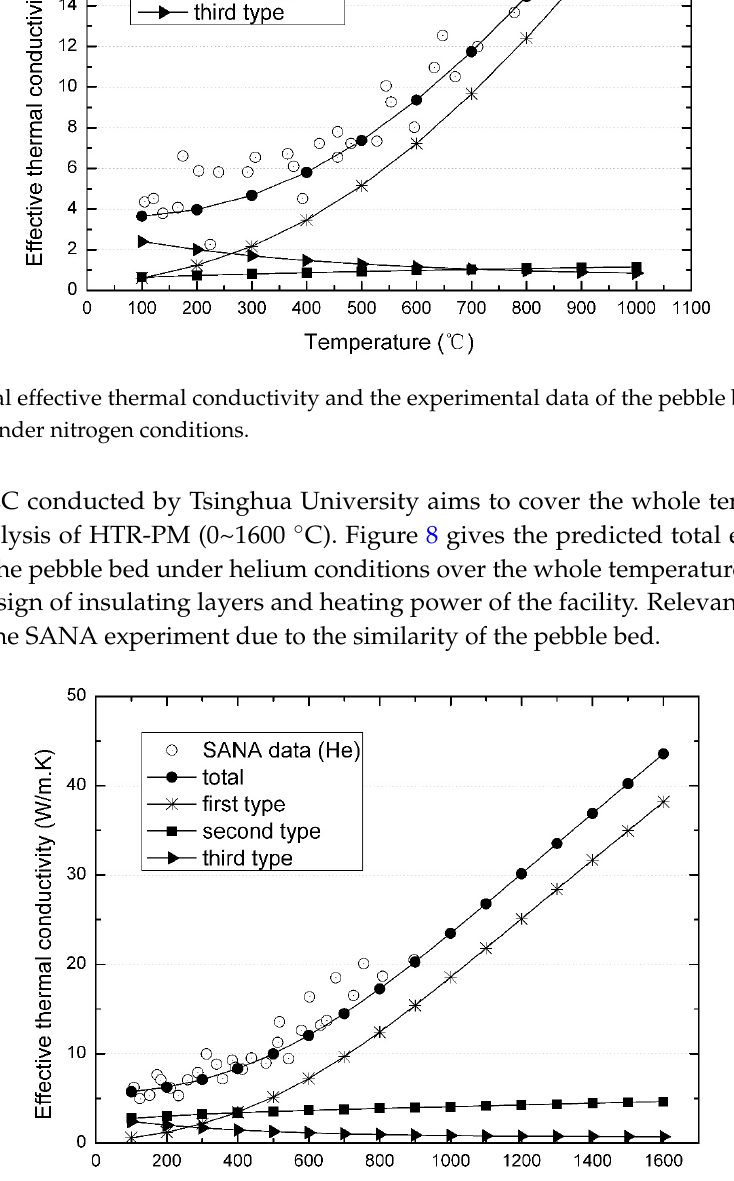
Figure 6. Total effective thermal conductivity and the experimental data of the pebble bed in SANA experiment under helium conditions.